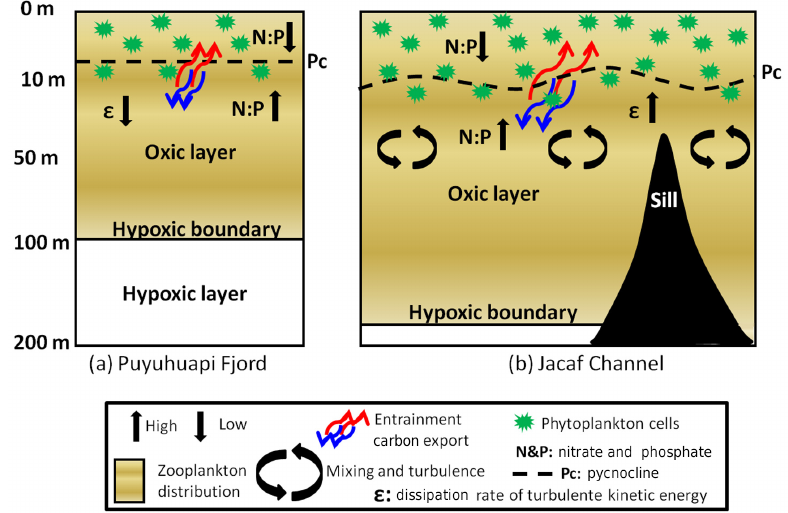
Figure 13. Conceptual model to show the oceanographic processes that contribute to the distribution and aggregation of zooplankton in (a) Puyuhuapi Fjord and (b) Jacaf